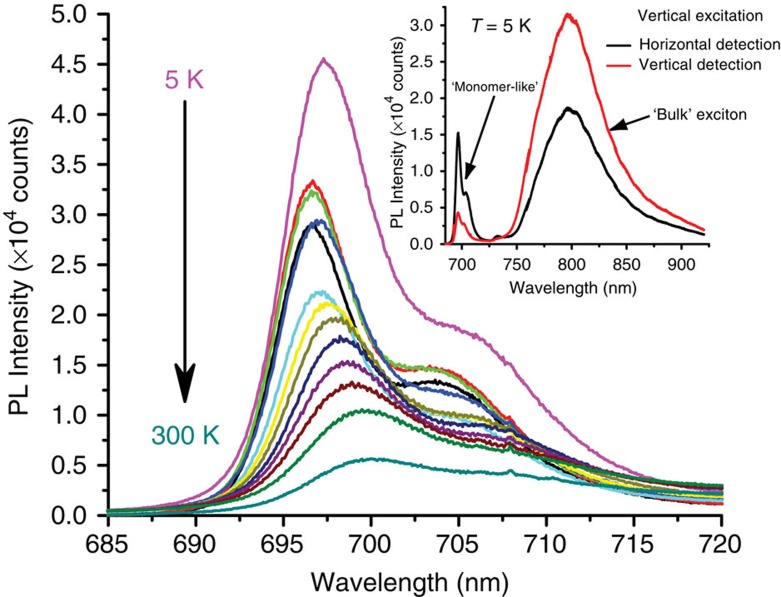
Temperature evolution of luminescence from grain boundaries.PL spectra from the grain boundary in Fig. 3d recorded at various temperatures between 5 and 300 K. The sharp, ‘monomer-like' feature exhibits the typical evolution of radiative emission from highly localized electronic states: the spectrum redshifts and broadens with increasing temperature. The inset displays both x- and y-polarized components of the luminescence spectrum indicating the localized, grain boundary emission and the ‘bulk' photoluminescence have opposite polarizations.